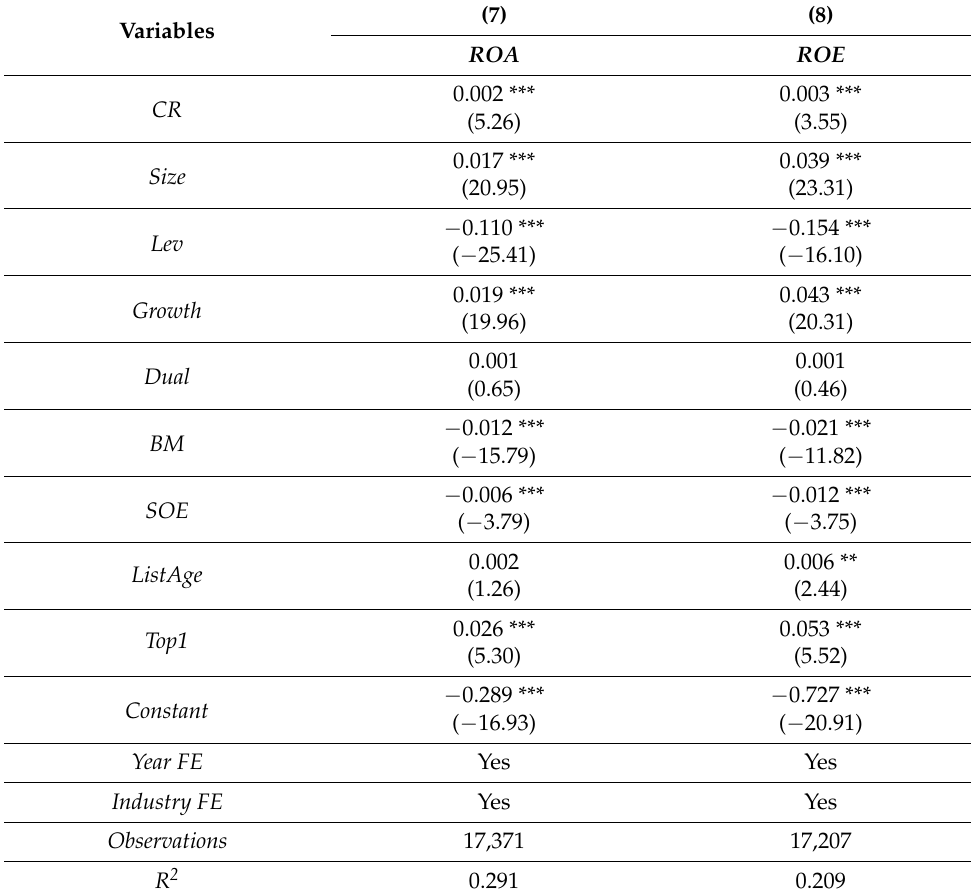
Table 6. Regression of supply chain power on business